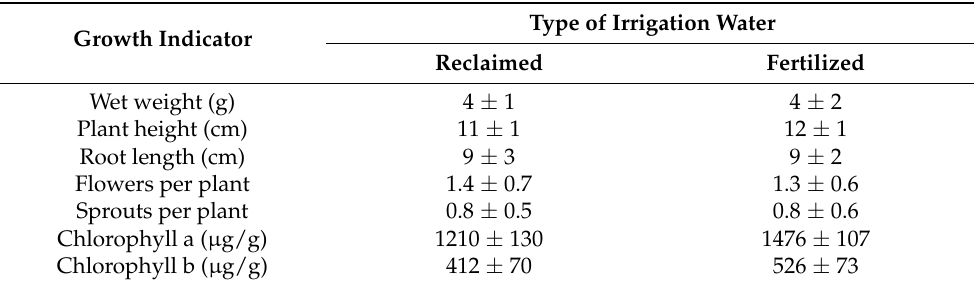
Table 4. Growth indicators of French marigold plants irrigated with reclaimed water compared to results obtained for the control sets 1 .